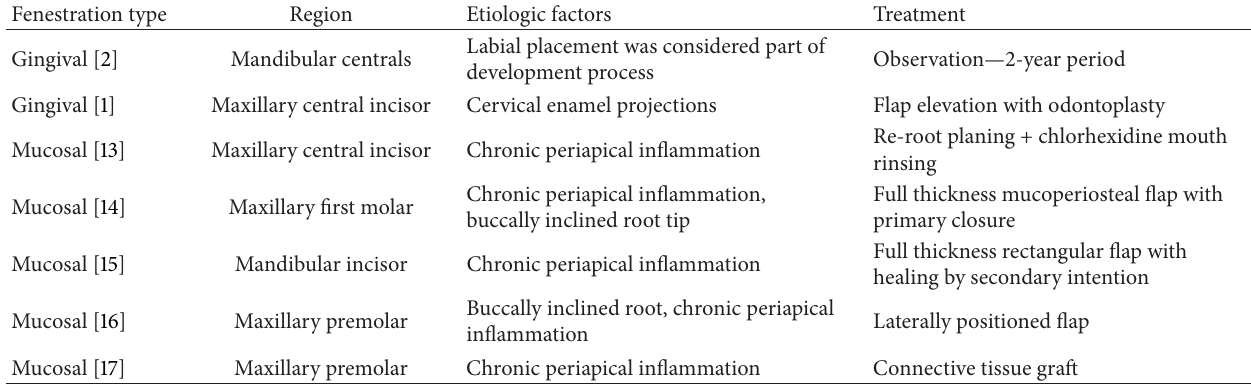
Table 1: Reported cases with fenestration and various treatment modalities